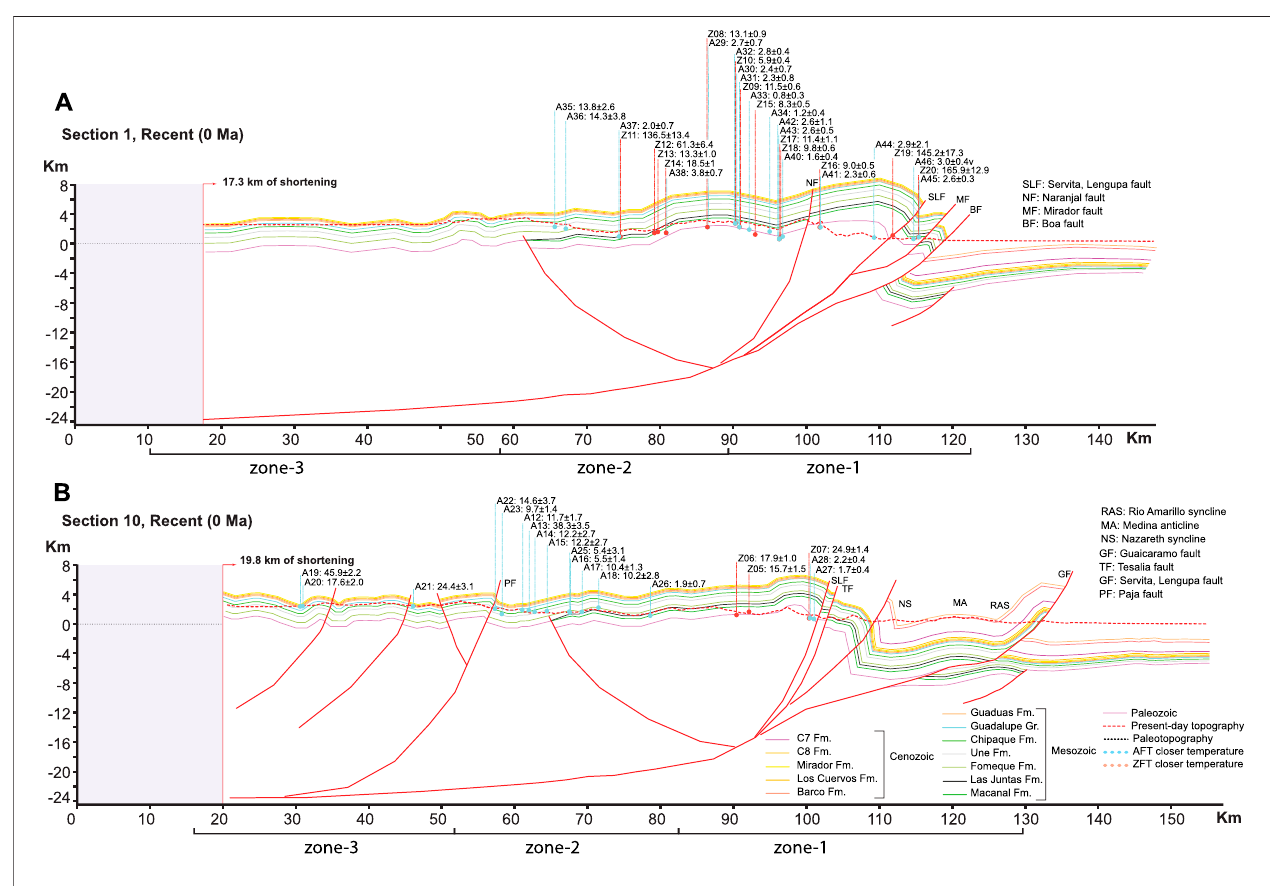
FIGURE 16 | Restoration to the present-day, (A) of Section 1, (B) of Section 10.